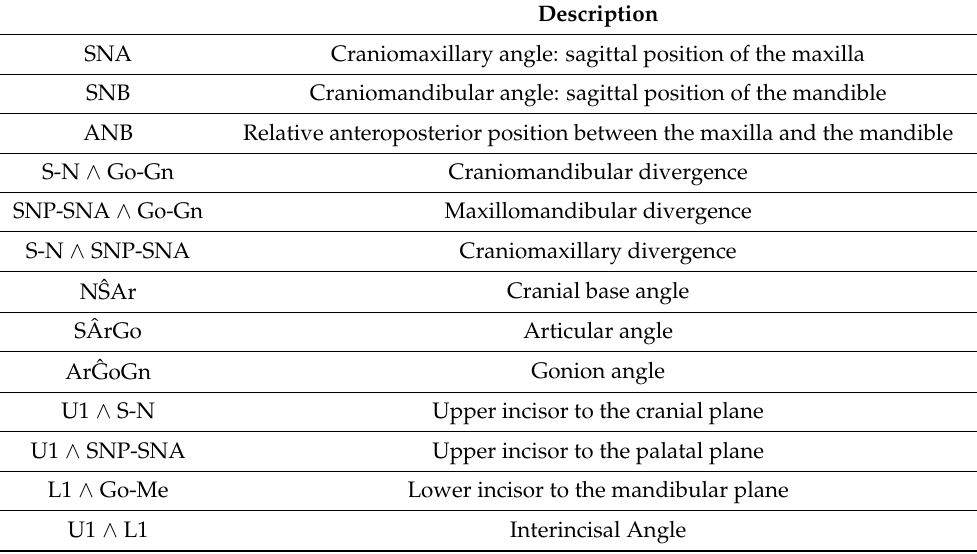
Table 1. Description of the considered cephalometric indexes.